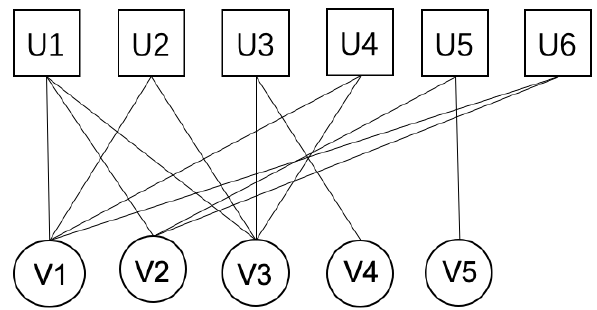
Figure 2. Bipartite network